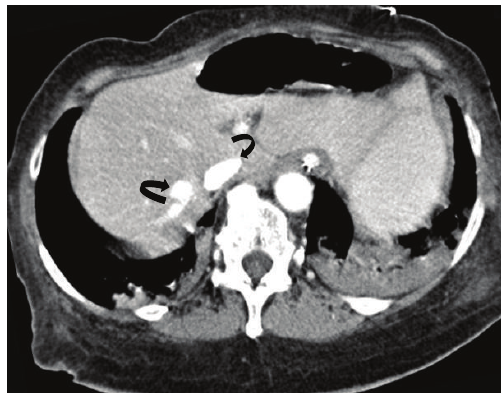
Figure 5: CT image of the liver shows normal contrast enhance- ment in the inferior vena cava and hepatic vein ( curved arrows ).